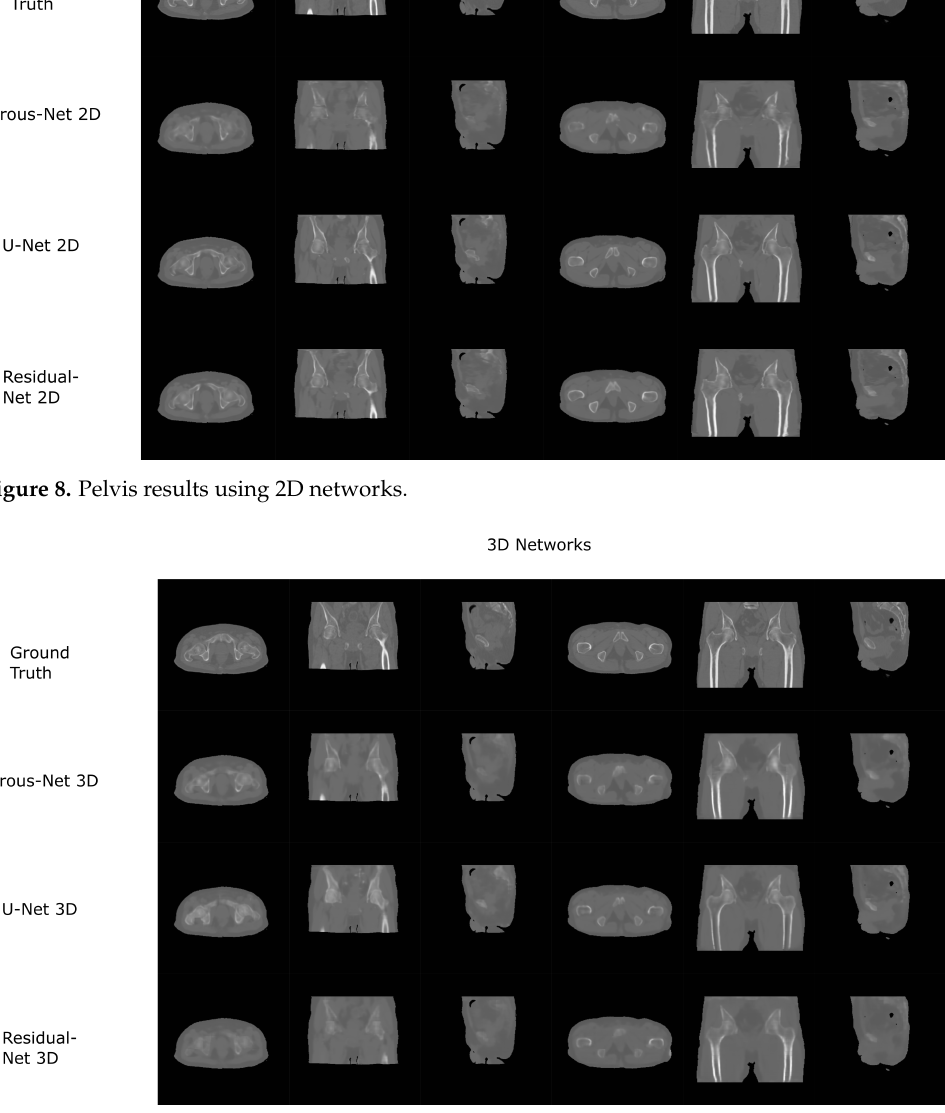
Figure 9. Pelvis results using 3D-16